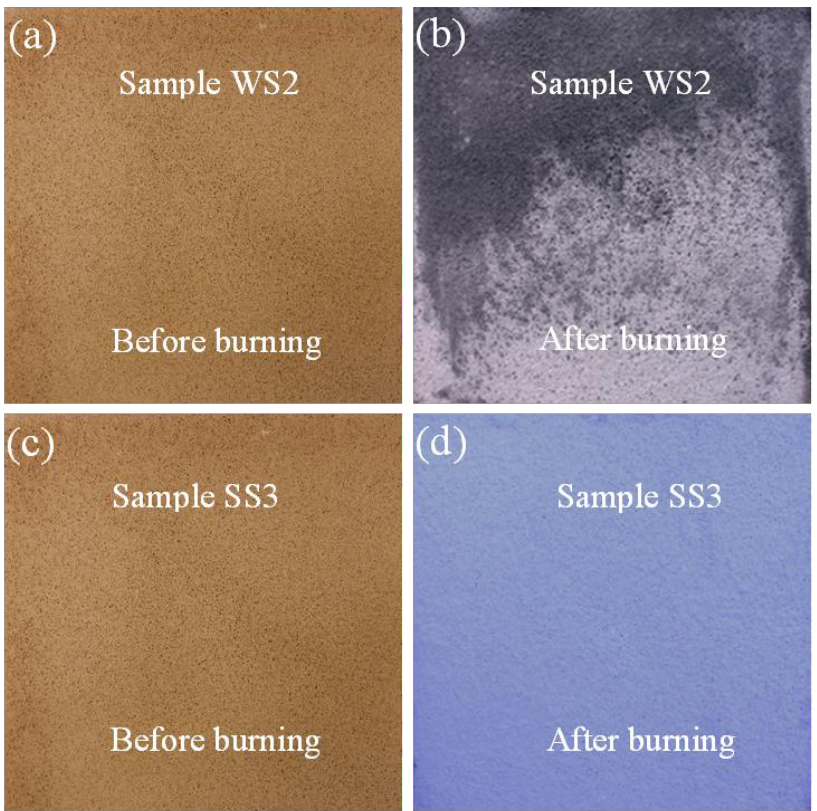
Figure 12. Photographs showing the fire-exposed surfaces of the samples WS2 and SS3: ( a ) and ( c ) before burning, ( b ) and ( d ) after burning.